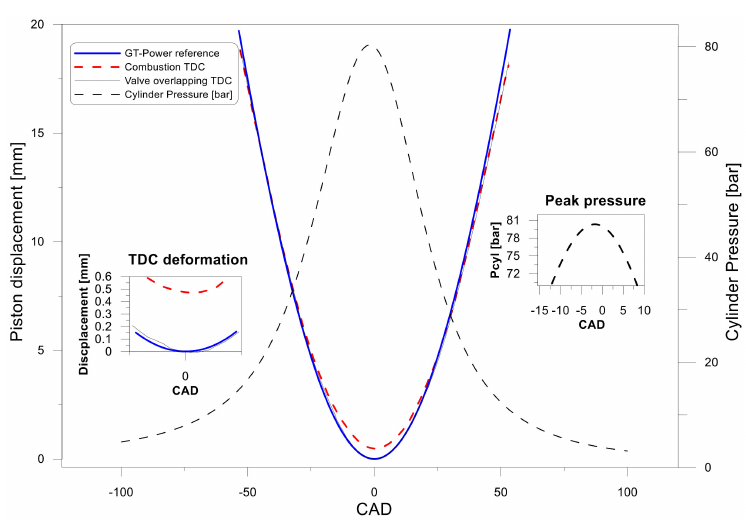
Figure 9. Maximum deformation at 1.1 bar of intake pressure.